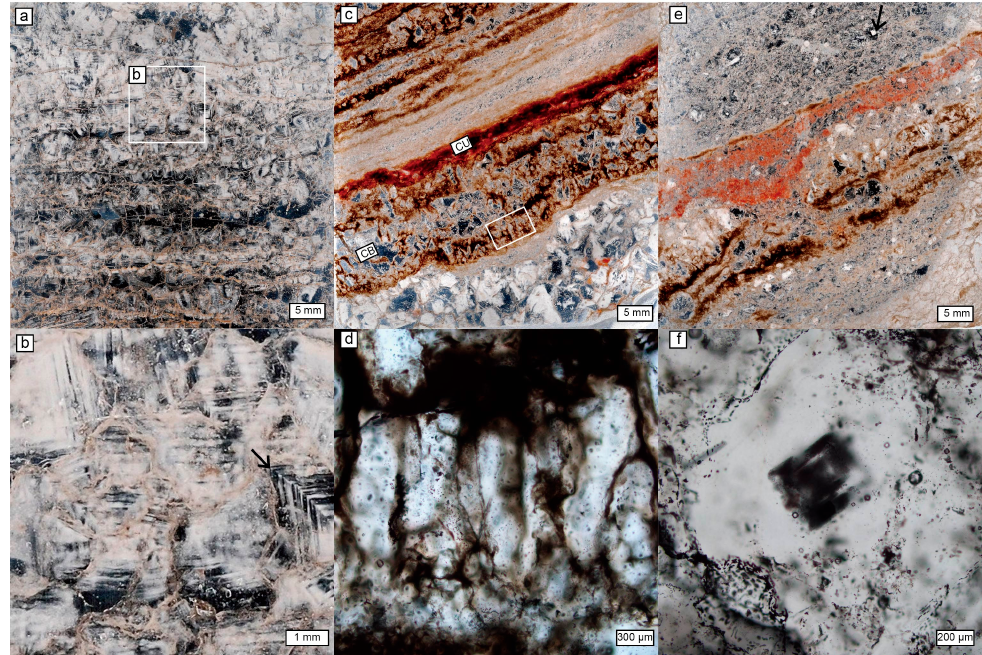
Figure 3. Thin section photomicrographs of halite from the Maha Sarakham Formation. ( a ) Vertically elongated halite crystals with dense clouds (white) of primary fluid inclusions. Core K79, 145 m; ( b ) enlarged area of Figure 3a. Vertically elongated chevron halite with alternations of fluid inclusion-rich (white) and fluid inclusion-poor (dark) bands (arrow); ( c ) chevron halite (white) at bottom, overlain by clear bottom-growth halite (CB) and cumulate halite (CU) stained red by microcrystalline hematite. Core RS2.6, 154 m; ( d ) enlarged rectangular area of Figure 3c. Clear bottom-growth halite crystals exhibit vertically elongated growth fabrics; ( e ) cumulate halite with scattered crystals dense with fluid inclusions (white patches-black arrow). Red layer in the middle contains cumulate halite and sylvite crystals. Core RS2.10, 89 m; ( f ) photomicrograph of cumulate halite crystal (indicated by black arrow in Figure 3e) with dense cloudy fluid inclusions (dark center).